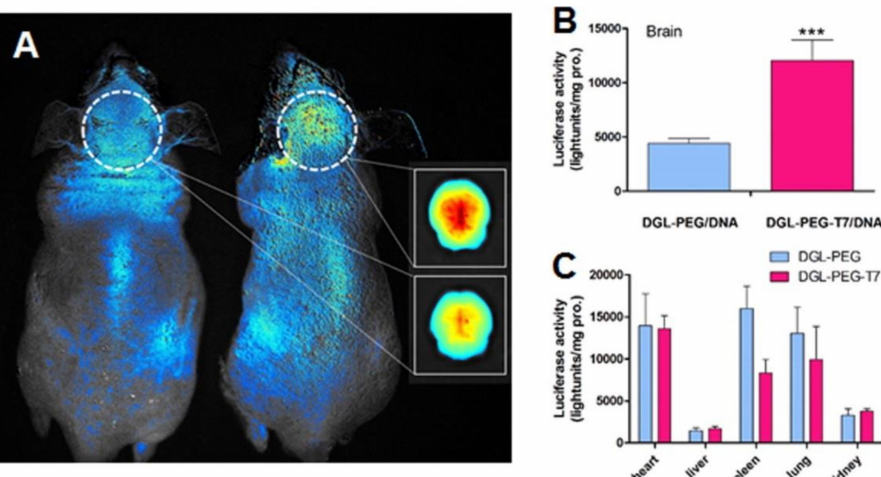
Figure 6. ( A ) In vivo imaging after i.v. administration of ethidium monoazide bromide-labeled control dendrimers (left) and T7-modified dendrimers in nude mice. The inset show the relative brain accumulation of control (upper) and T7-modified dendrimers (lower). ( B , C ) The quantitative evaluation of gene expression in vivo. Luciferase expression 48 h after i.v. administration of control and T7-modified dendrimers into nude mice. Luciferase expression of brain ( B ) and other solid organs ( C ) is plotted as light units per mg protein. *** p < 0.001 compared with the control dendrimers. Data are expressed as mean ± SD ( n = 4). Reproduced with permission from [94], published by Elsevier,